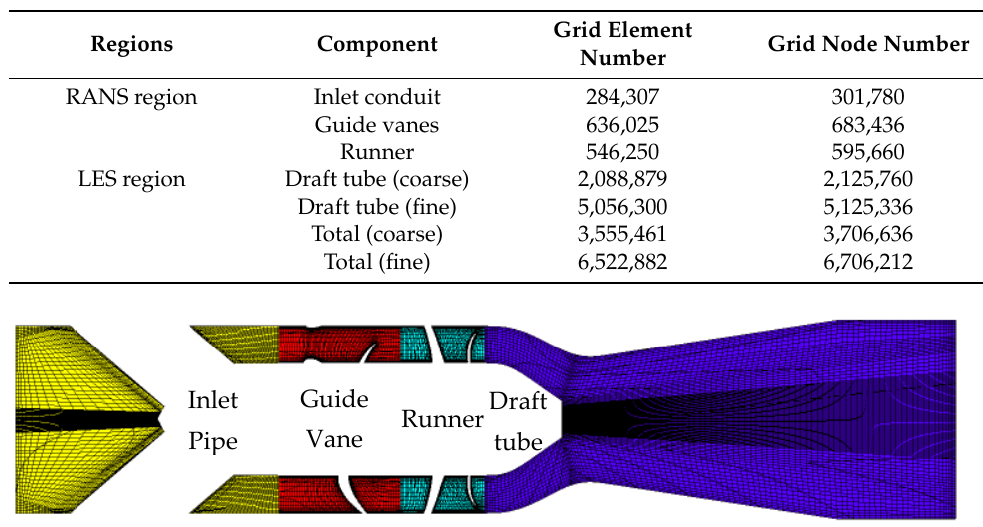
Table 2. Grid details.